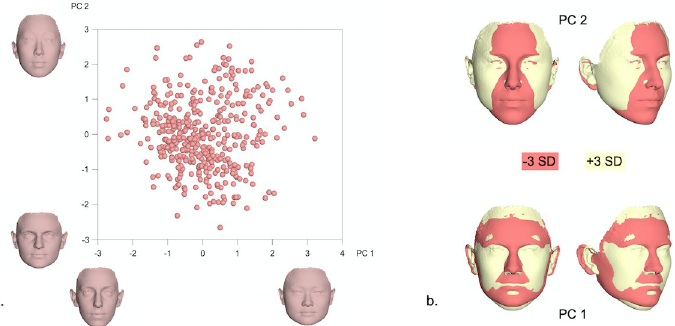
Fig 3. a. PCA graph displaying facial shape variation in females (in SD units), as explained by PC1 (21%) and PC2 (15.1%). The corresponding 3D facial morphings show the shape extremes from -3 to +3 standard deviations of PC scores within each axis. b. Best fit superimpositions of shape transformations created from the Procrustes coordinates corresponding to -3SD and +3SD of PC scores within each axis from the average shape configuration in the female population. The superimpositions display the direction of shape variation explained by each